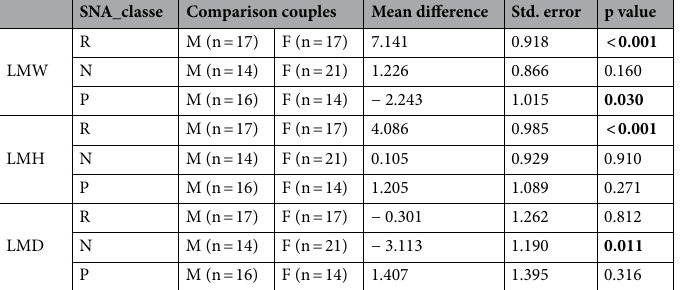
Table 5. Simple main effects: Effect of gender on MS measurements at each level of SNA angle. Significant values are in bold. A p value < 0.05 was considered statistically significant.